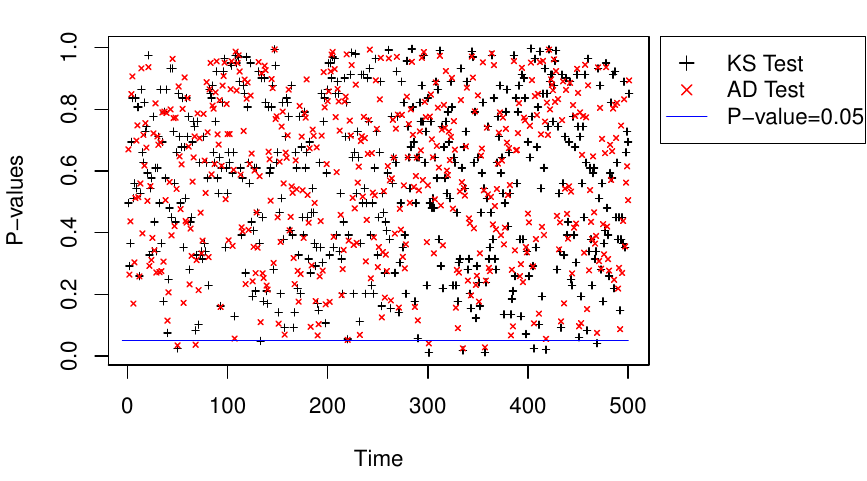
Figure 8. P-values of the KS and AD statistics for the Dow Jones